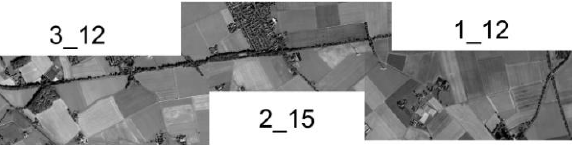
Figure 1: Overlay of corresponding SkySat Basic images captured by the SkySat SSC12’s three CMOS-frame sensors